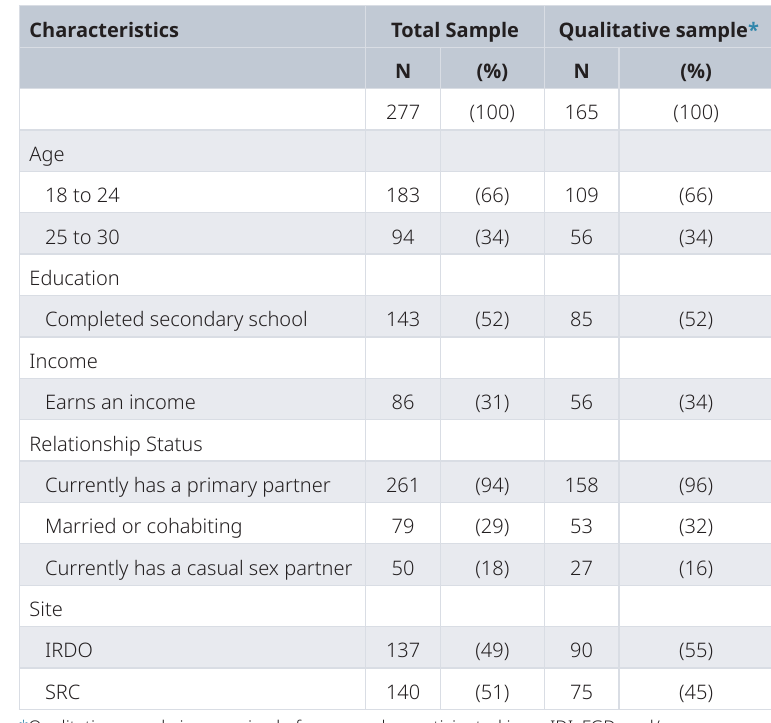
Table 3. Background characteristics of TRIO